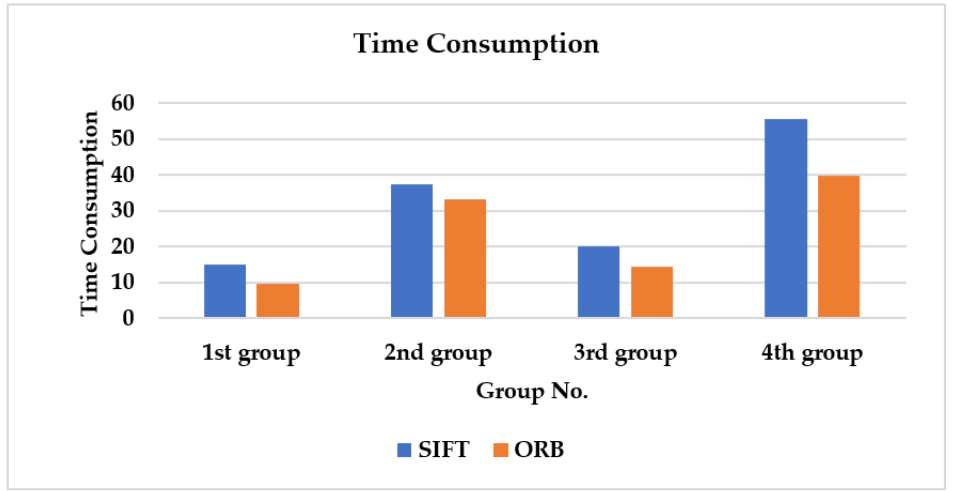
Figure 12. Time consumed for feature extraction over the four groups created from ImageNet-Sketch dataset using handcrafted features.